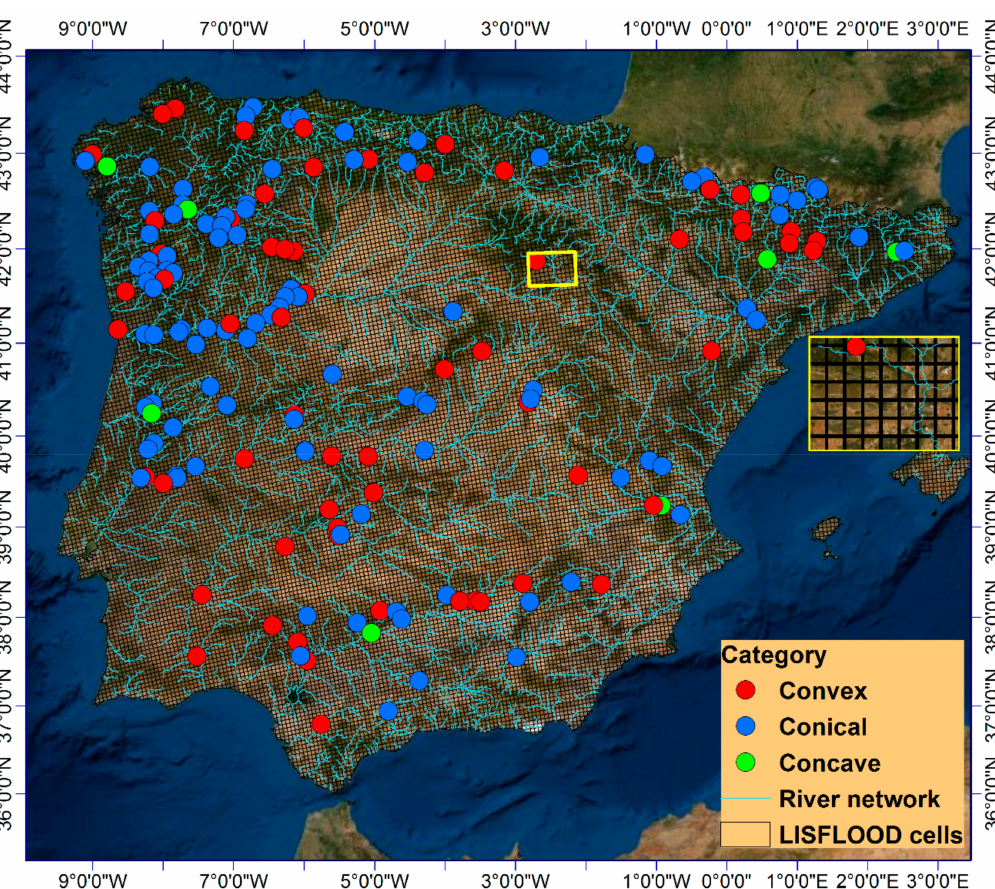
Figure 1. Location of the studied reservoirs, their categorization and zoomed LISFLOOD grid mesh.